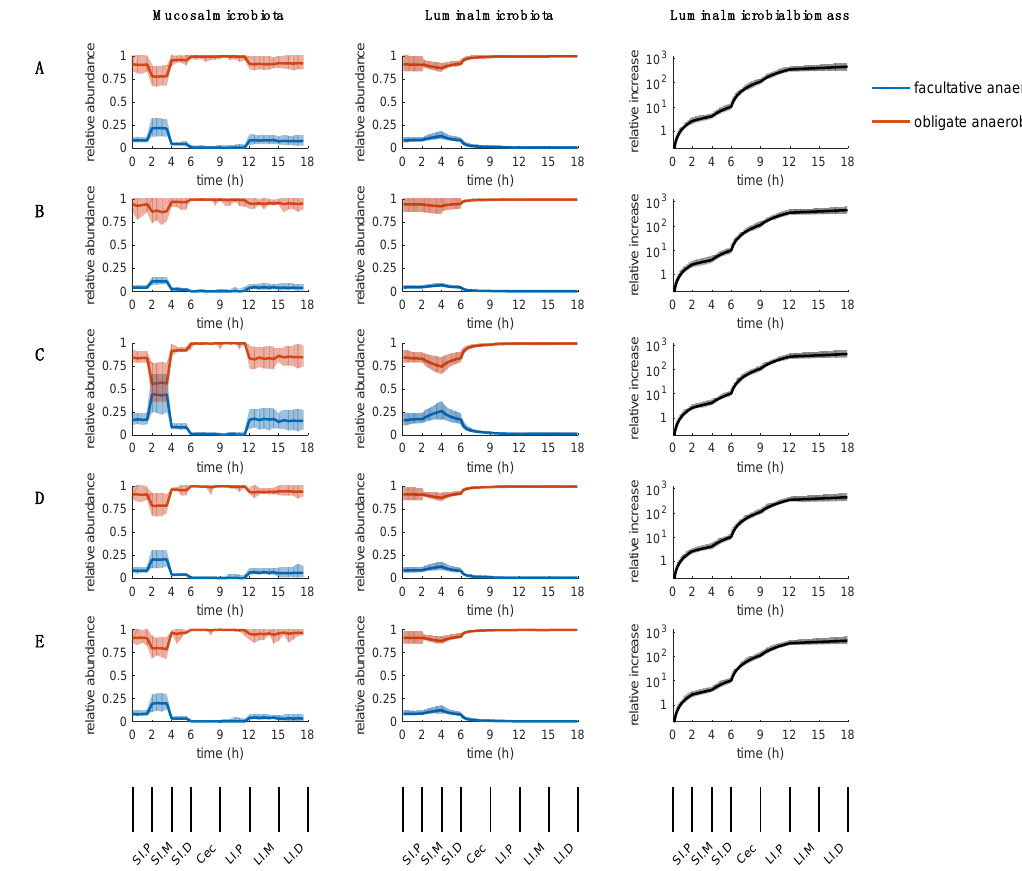
Figure 5. Varying the total oxygen available to the gut microbiota r total oxygen as detailed in Table 3. ( A ) Default, 1.6 × 10 − 6 mmol h − 1 g − 1 . ( B ) Test 1, 0.8 × 10 − 6 mmol h − 1 g − 1 . ( C ) Test 2, 3.2 × 10 − 6 mmol h − 1 g − 1 . ( D ) Test 3, uniformly decreasing from 1.6 × 10 − 6 to 1.12 × 10 − 6 mmol h − 1 g − 1 . ( E ) Test 4, uniformly decreasing from 1.6 × 10 − 6 to 0.64 × 10 − 6 mmol h − 1 g − 1 .